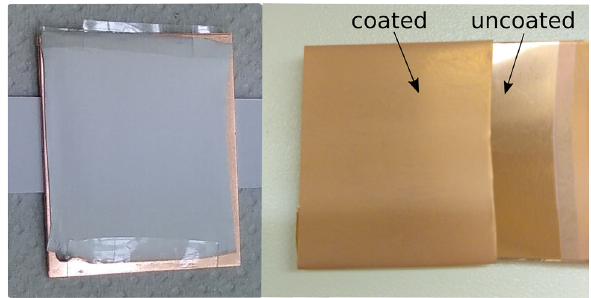
Fig. 3 A TTX sample attached to a copper plate (left) and a copper foil partially evaporated with TPB (right). The TPB coating changes the appearance of the foil, which becomes slightly white and